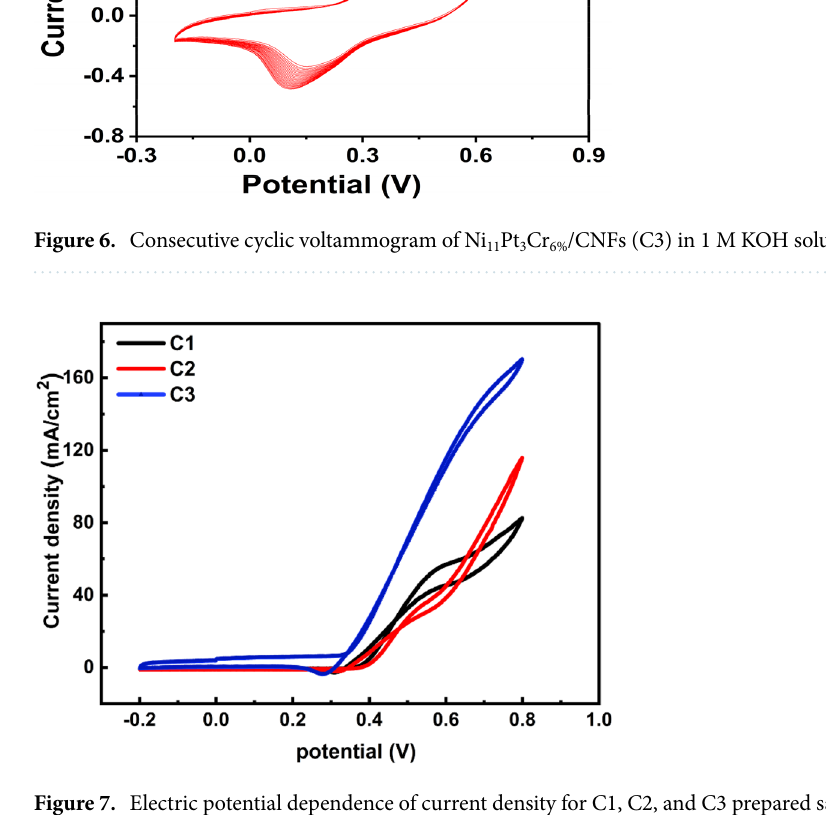
Figure 7. Electric potential dependence of current density for C1, C2, and C3 prepared